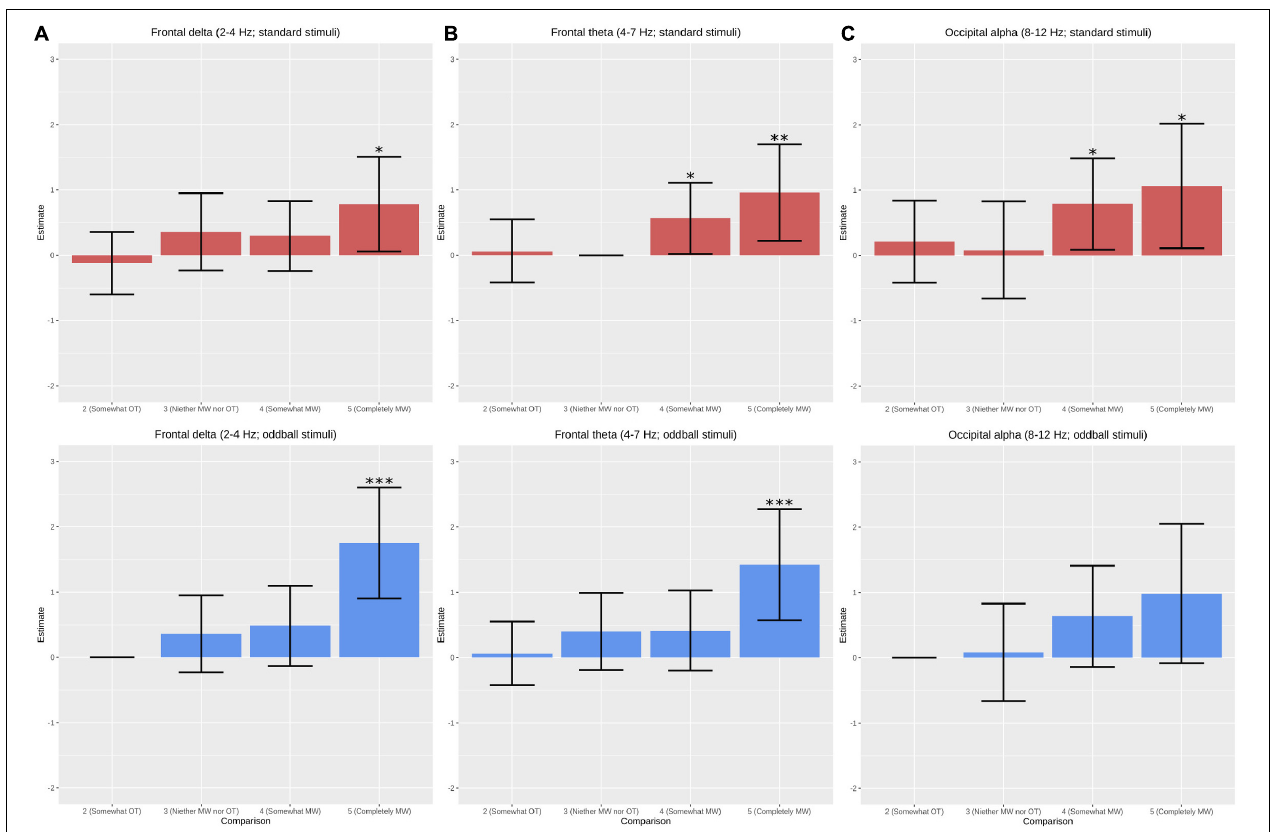
FIGURE 4 | Comparisons of frequency band power (dB) estimates from linear mixed effects analysis using the “completely on task” state (1 on the Likert scale) as the reference variable. (A) Delta frequency band power in the frontal region is significantly higher during the “completely mind wandering” state and in response to oddball stimuli. (B) Frontal theta power is significantly higher during both “somewhat” and “completely” mind wandering states. (C) Alpha power in the occipital region is significantly higher during “somewhat” and “completely” mind wandering states though was only found to be significant in response to standard auditory stimuli. No significant results were found at the beta frequency band. *Denotes significant at α = 0.05; **denotes significant at α = 0.01; ***denotes significant at α =